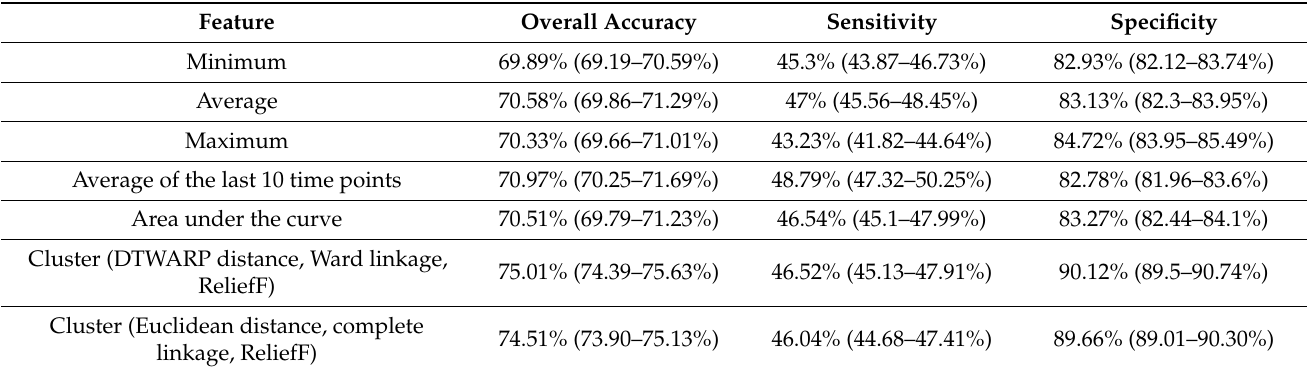
Table 2. Classification results using Random